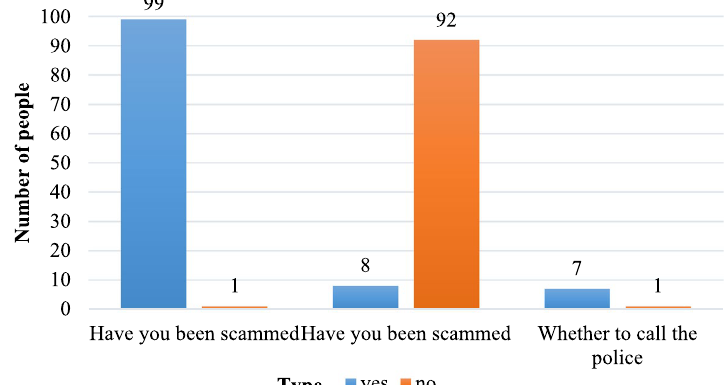
Fig. 8 Investigation on Fraud